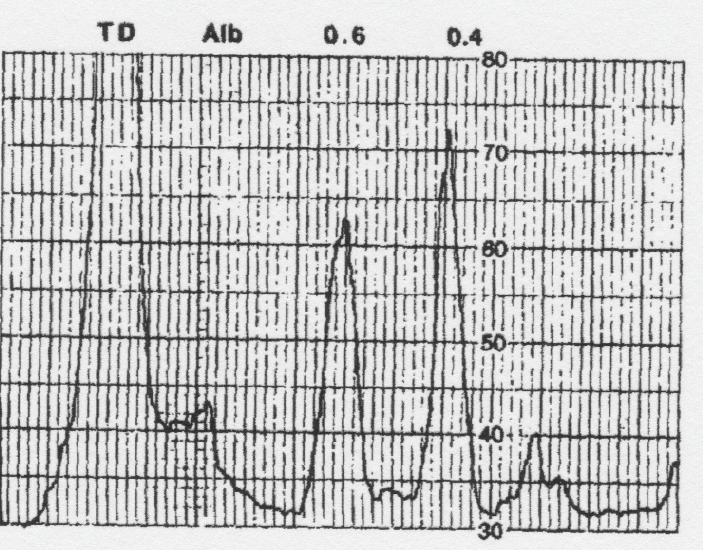
Figure 4. Native (non-denaturing) PAGE, in tube gels, of semi-purified rat ceruloplasmin, as detected by UV absorbance scanning of the gel at 280 nm. The top of the gel is at the right; the bottom, showing the tracking dye (TD), is on the left. Some albumin (Alb) was still present. Holo and apo ceruloplasmins migrated with Rfs of about 0.6 and 0.4, respectively. The resolving gel was 5% polyacrylamide, resolving buffer pH 8.8. Reprinted with permission from Middleton and Linder [28]. Biomedicines 2021 , 9 , x FOR PEER REVIEW